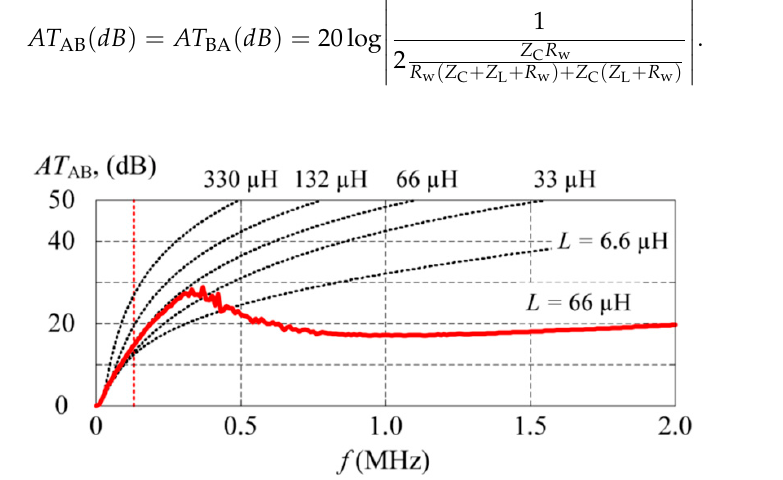
Figure 7. Insertion loss characteristics of the experimental LC filter with the ideal characteristics given for different inductance values and a fixed capacitance of C = 200 nF.